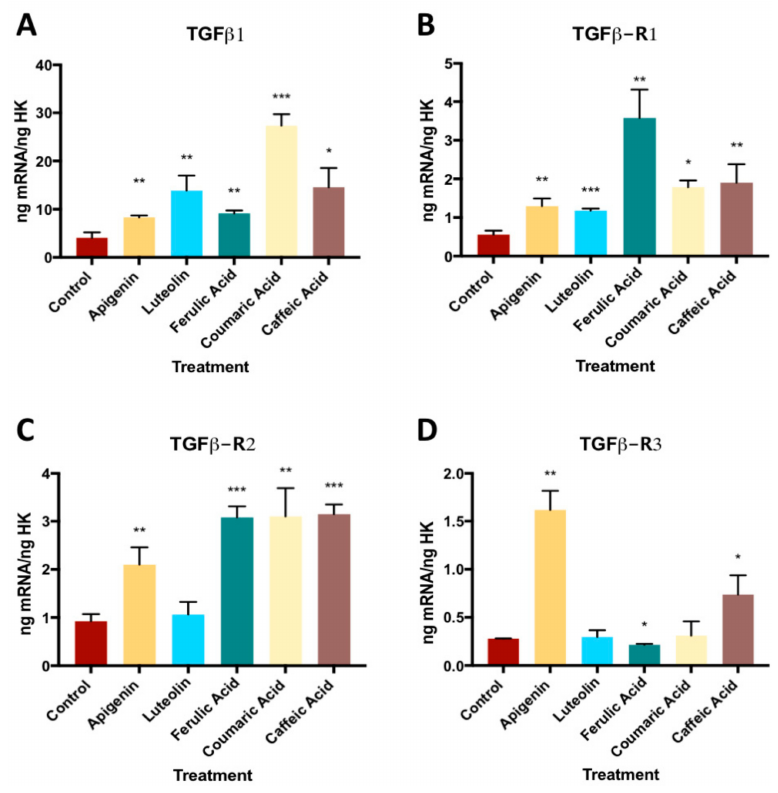
Figure 1. The e ff ect of phenolic compounds on gene expression of TGF β 1 and its receptors (TGF β -R1, TGF β -R2, and TGF β -R3). * p < 0.05, ** p < 0.005, *** p < 0.001. TGF- β 1: Transforming growth factor β 1, TGF- β receptor 1,2 and 3 (TGF- β R1, TGF- β R2, TGF- β R3).